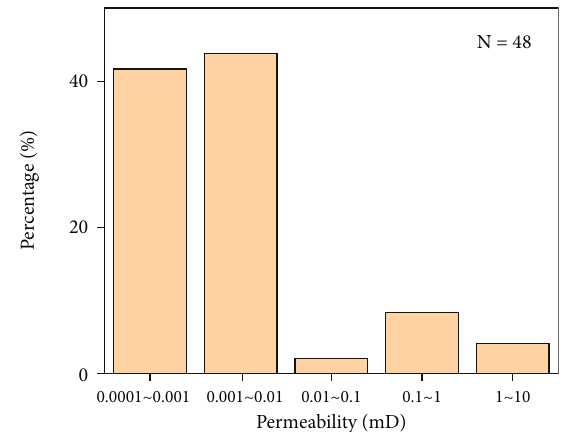
Figure 10: Histogram showing the frequency distribution of